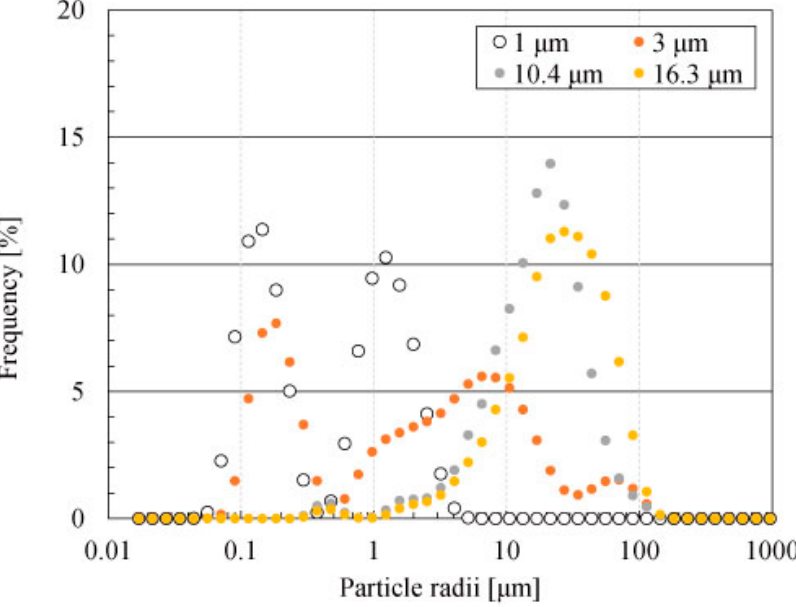
Figure 1. Particle radii of each powder (1 µ m, 3 µ m, 10.4 µ m and 16.3 µ m) investigated by a laser-diffraction-type particle size distribution measuring device.